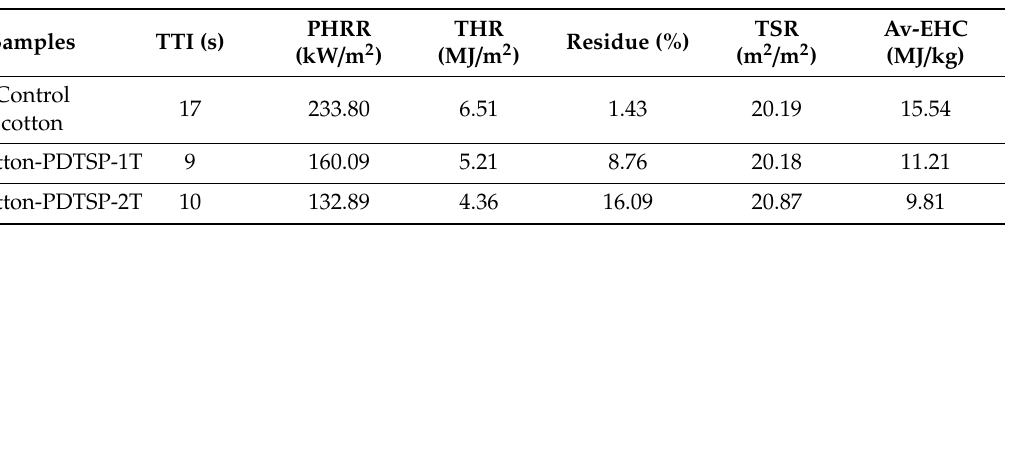
Table 4. Cone calorimetry data for control cotton and PDTSP-coated cotton